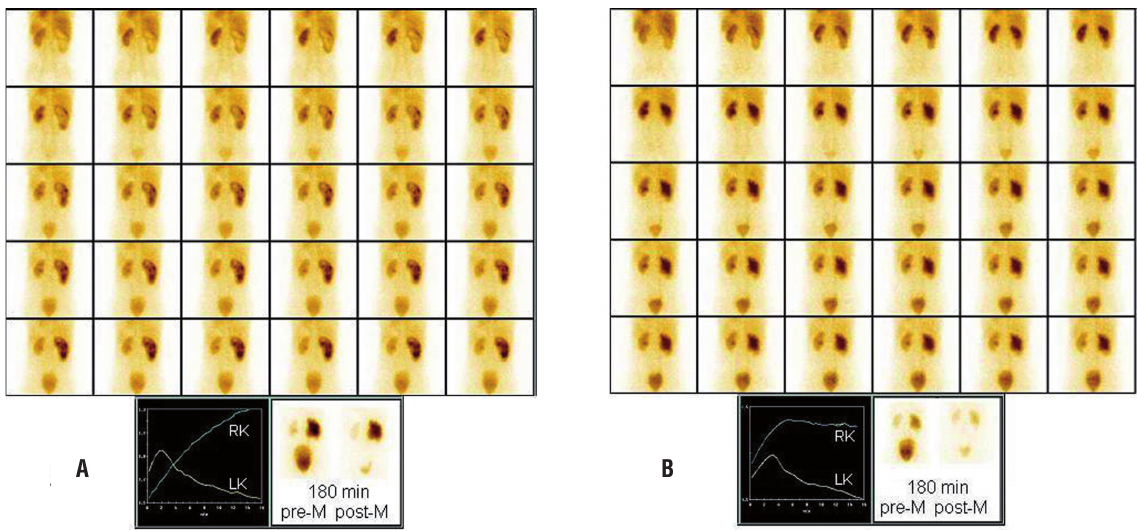
A - preoperative: obstruction of the ureteropelvic junction (OJUP) in the right kidney by the criteria of renographic curve and decreases in kidney counts in the late images (LOF right kidney = -0.6%; LOF left kidney = 77.2%). B - after pyeloplasty: without OJUP (LOF right kidney = 83.9%; LOF left kidney =